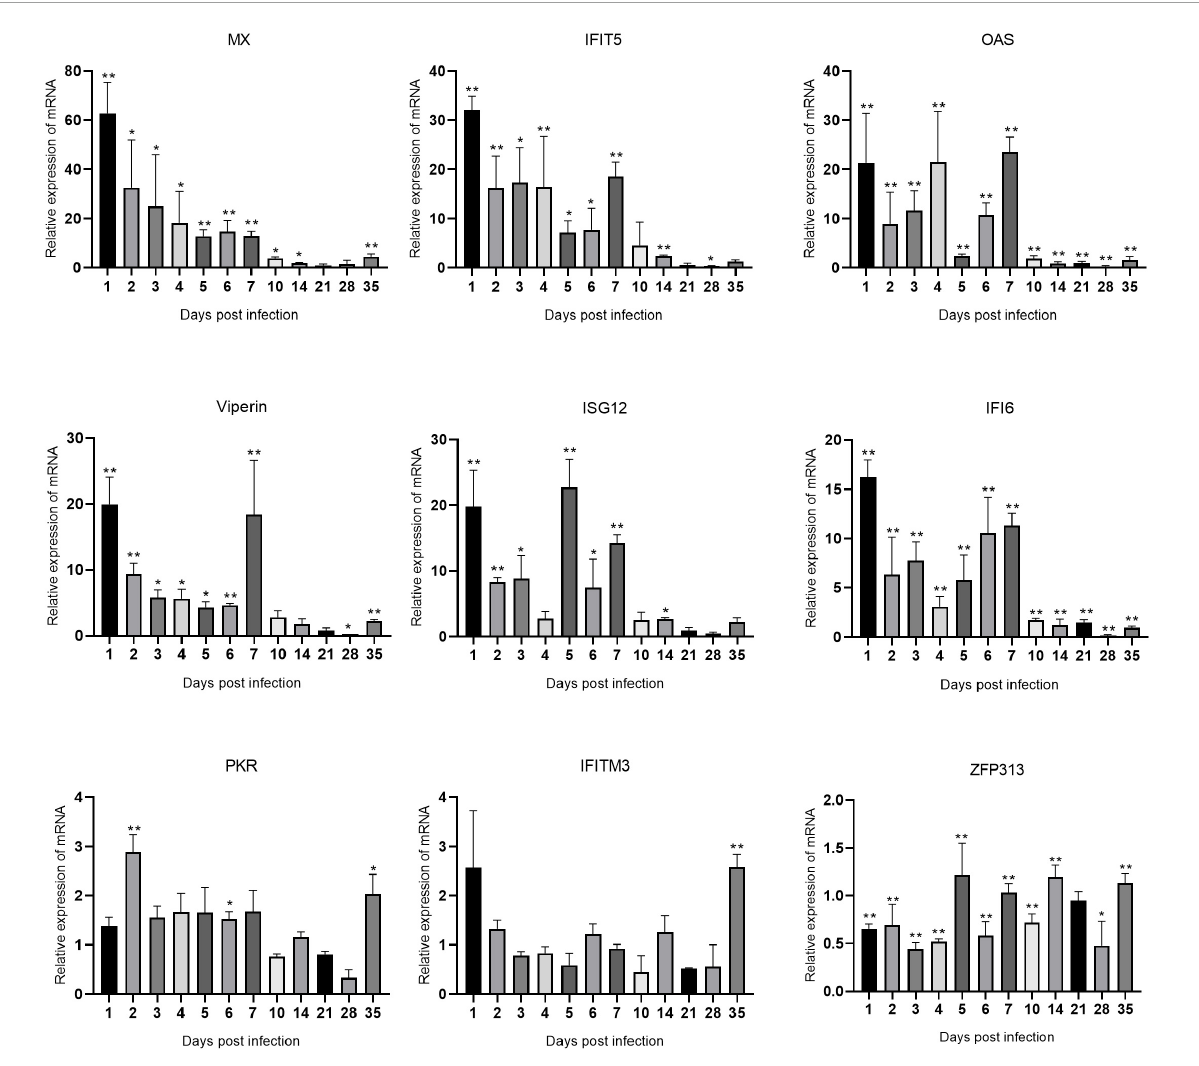
FIGURE5 Changes in ISG transcription levels in the spleen after ARV infection. ARV strain S1133 (10 4 TCID 50 /0.1 ml) was used to infect chickens through the footpad. At 1, 2, 3, 4, 5, 6, 7, 10, 14, 21, 28, and 35 days after infection (dpi), three chickens were randomly collected from each group, and changes in ISG mRNA levels in the spleen were measured by real-time quantitative PCR. The data are the mean ± SD of three independent experiments. Asterisks indicate significant differences (* P < 0.05, ** P <